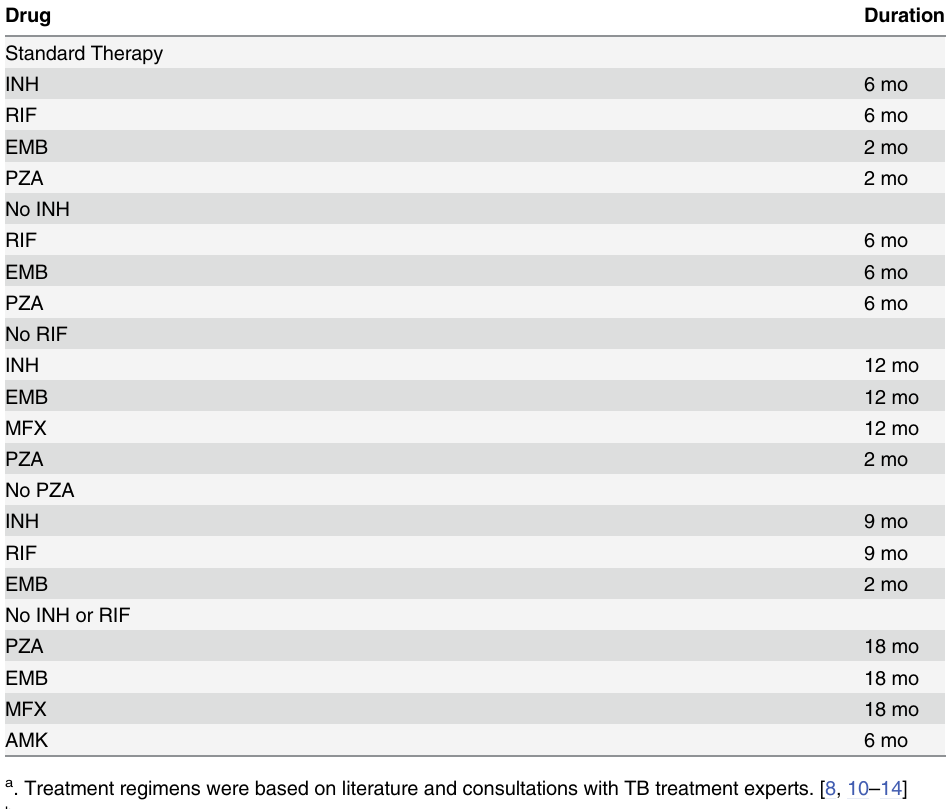
Table 1. Regimens for the treatment of tuberculosis in a hypothetical cohort of TB patients in the set- ting of anti-TB drug shortages a,b .